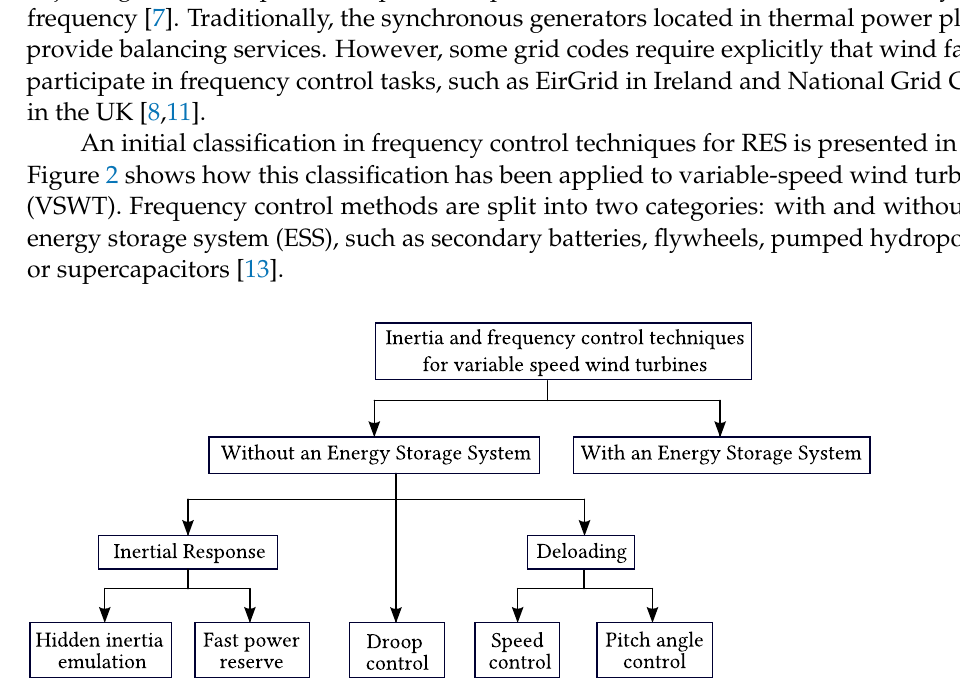
Figure 2. Inertia and frequency control technique design for variable-speed wind